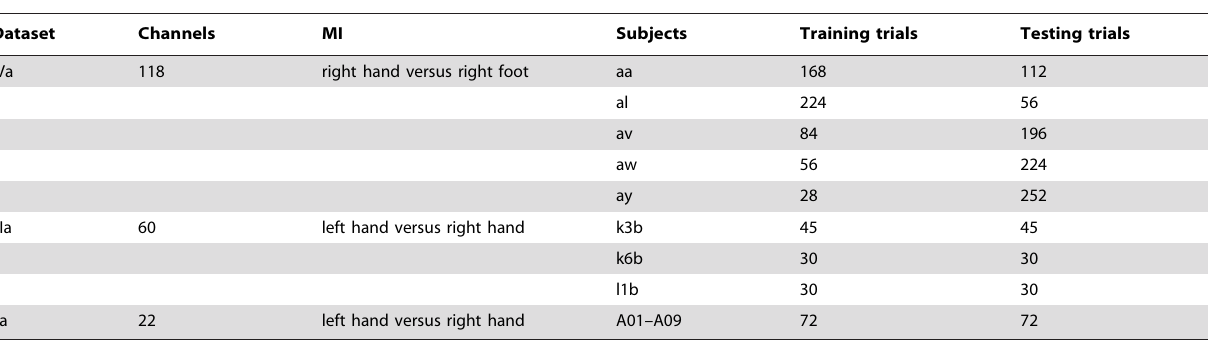
Table 1. Brief summary of MI datasets.